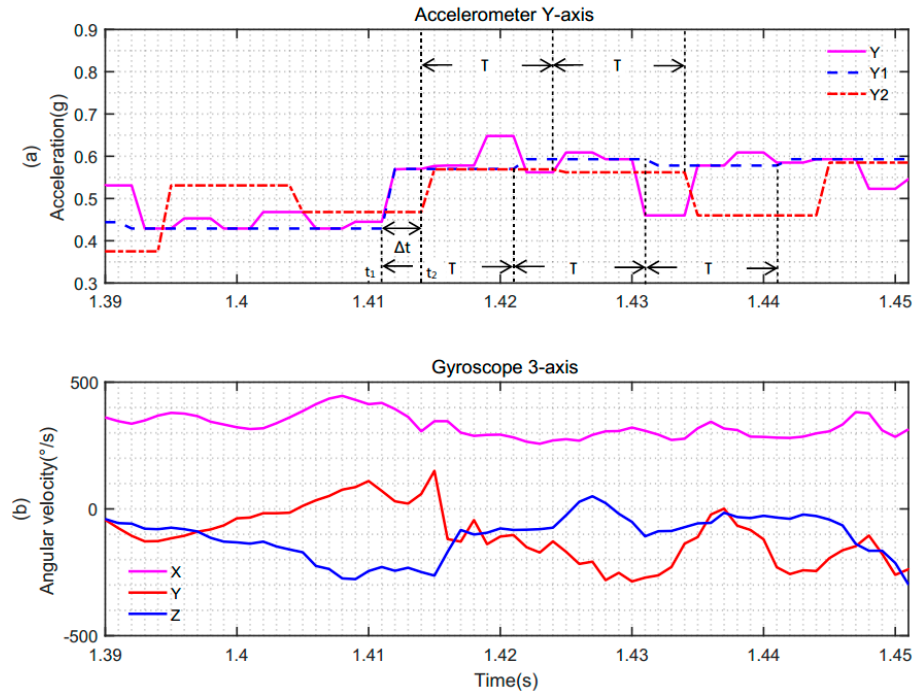
Figure 12. Comparisons of sampling instants of the accelerometer and gyroscope in the case of synchronous and asynchronous sampling. ( a ) Y -axis data of the accelerometer; ( b ) three-axis data of the gyroscope.